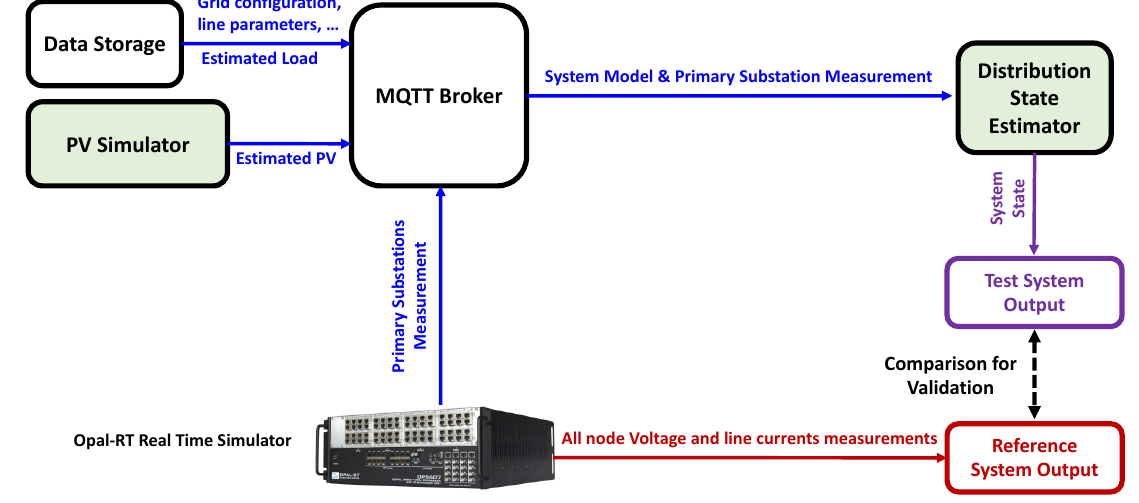
Figure 7. Test and reference system output